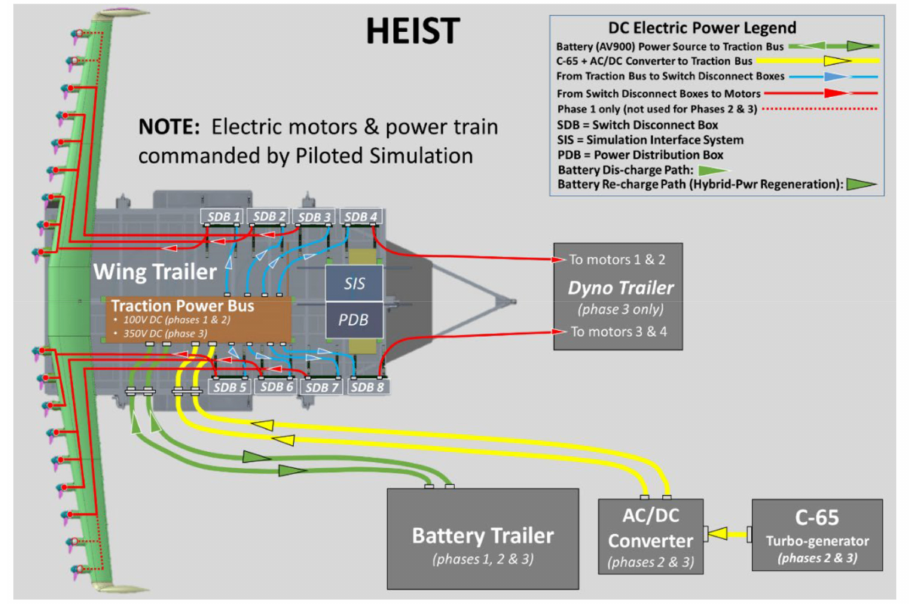
Figure 4. Hybrid Electric Integrated System Testbed (HEIST)—Concepts of operation view. Source: NASA